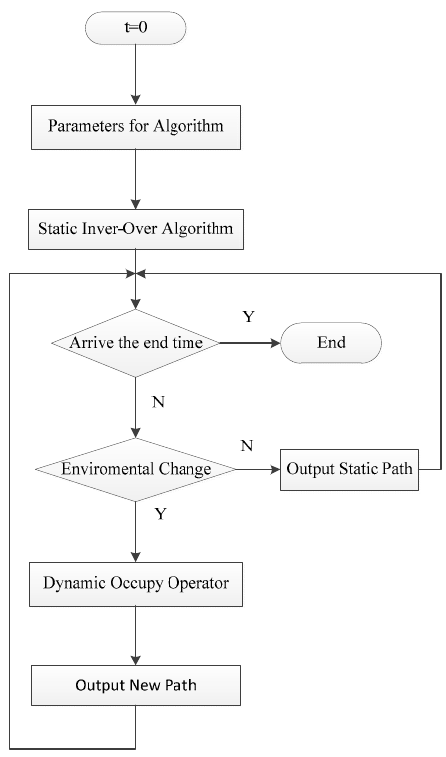
Figure 4. Flowchart of dynamic Inver-Over evolutionary algorithm.